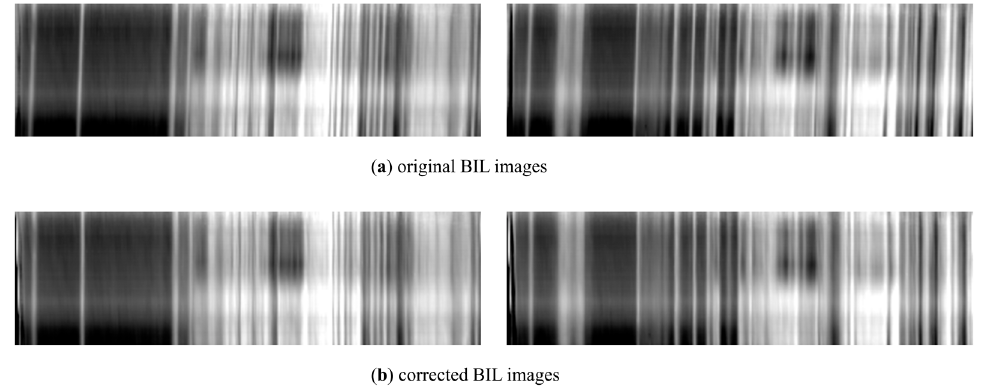
Figure 14. Comparison between ( a ) original BIL images and ( b ) corrected BIL images of two lines with spectral range from 8.3 μm to 10.5 μm .